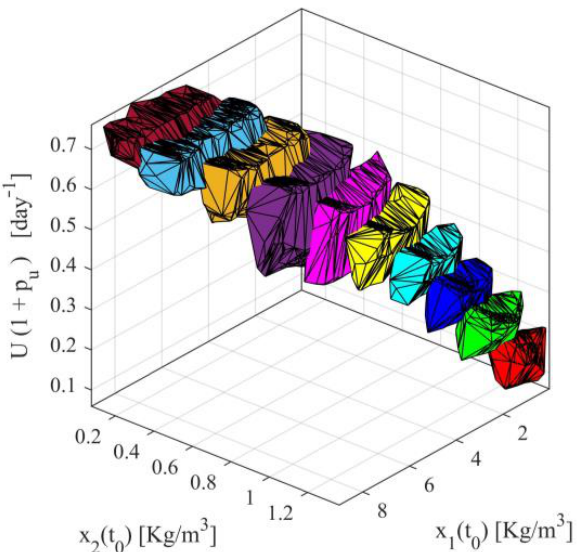
Figure 2. Acceptable input and initial condition sets for all scenarios.